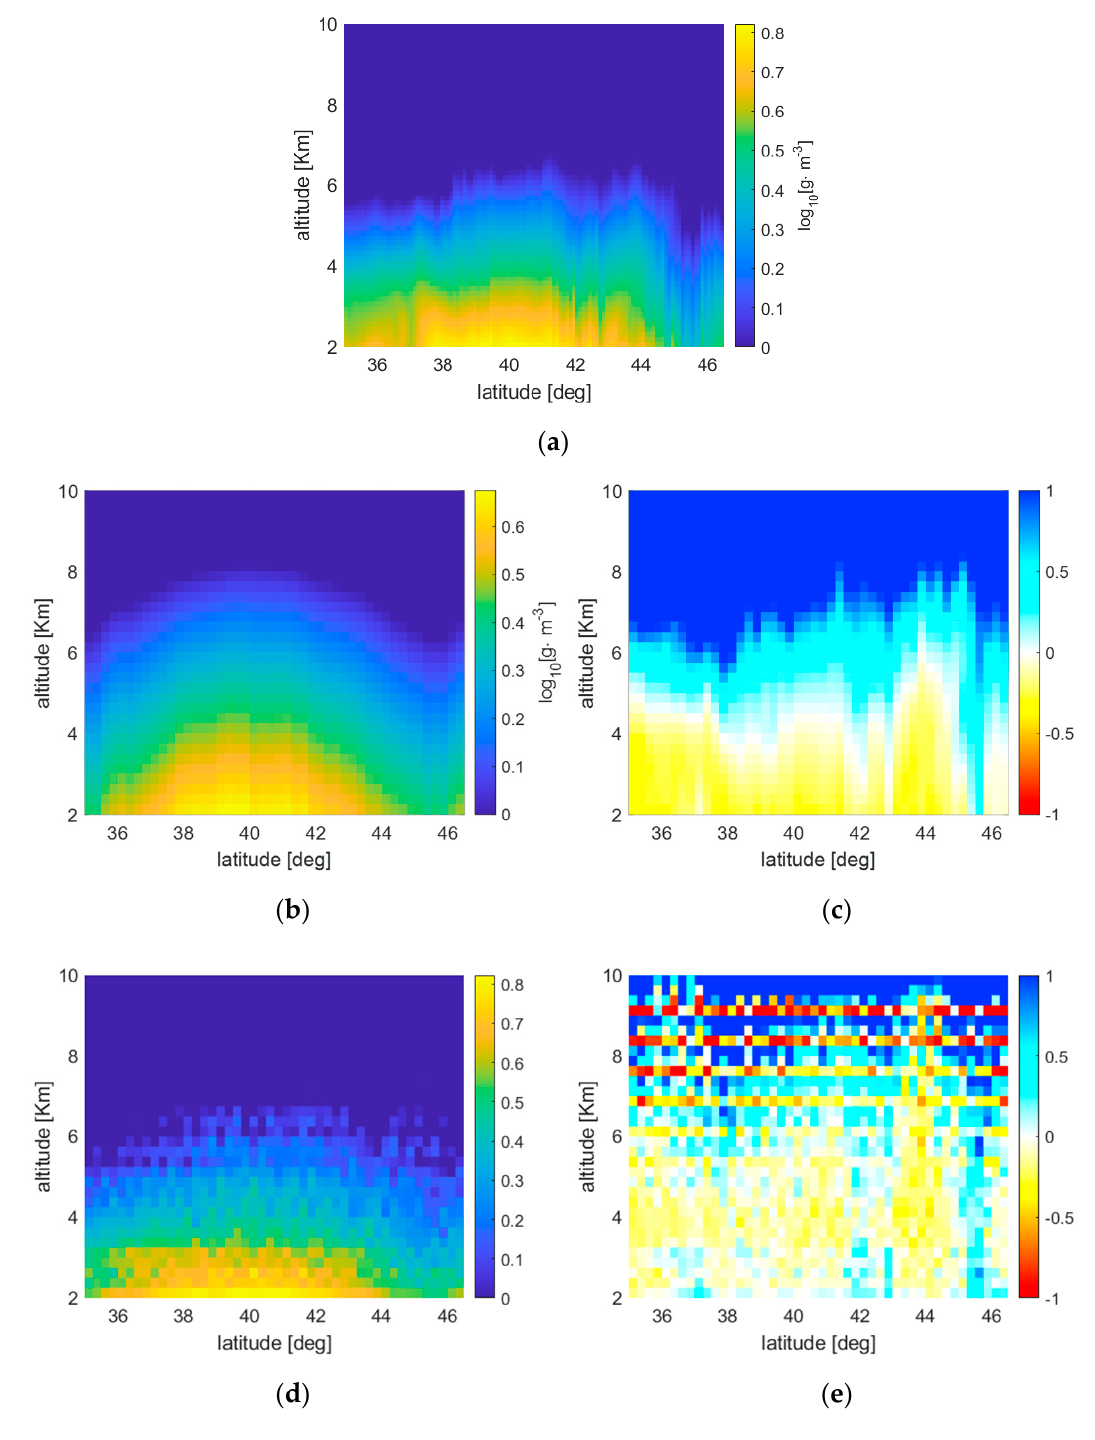
Figure 5. ( a ) True WV field (analysis of 24 September 2020 9 p.m.) as a function of angle and altitude; ( b ) retrieved WV field with ERTA and ( c ) the corresponding normalized error field; ( d ) retrieved WV field with LSATR and ( e ) the corresponding normalized error field defined as in Equation (17). Satellite configuration: 1Tx ‐ 10Rx.